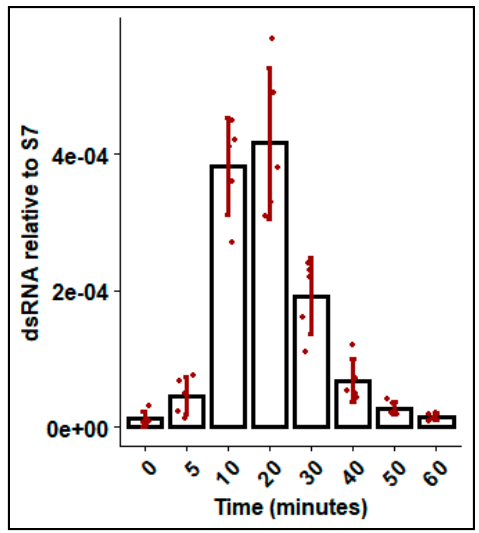
Figure 5 . DsRNA recovered in hemolymph following soaking in dsGus for durations between 0 and 60 minutes. Fourth instar Ae. aegypti larvae were soaked in ~350 bp dsGus dsRNA 0.1 ng/uL and hemolymph was removed by microcapillary and dsRNA was measured by qRT-PCR, with ribosomal S7 used as a reference gene. Error bars represent standard deviations and bars represent mean of biological replicates (n = 4), shown as jittered points.